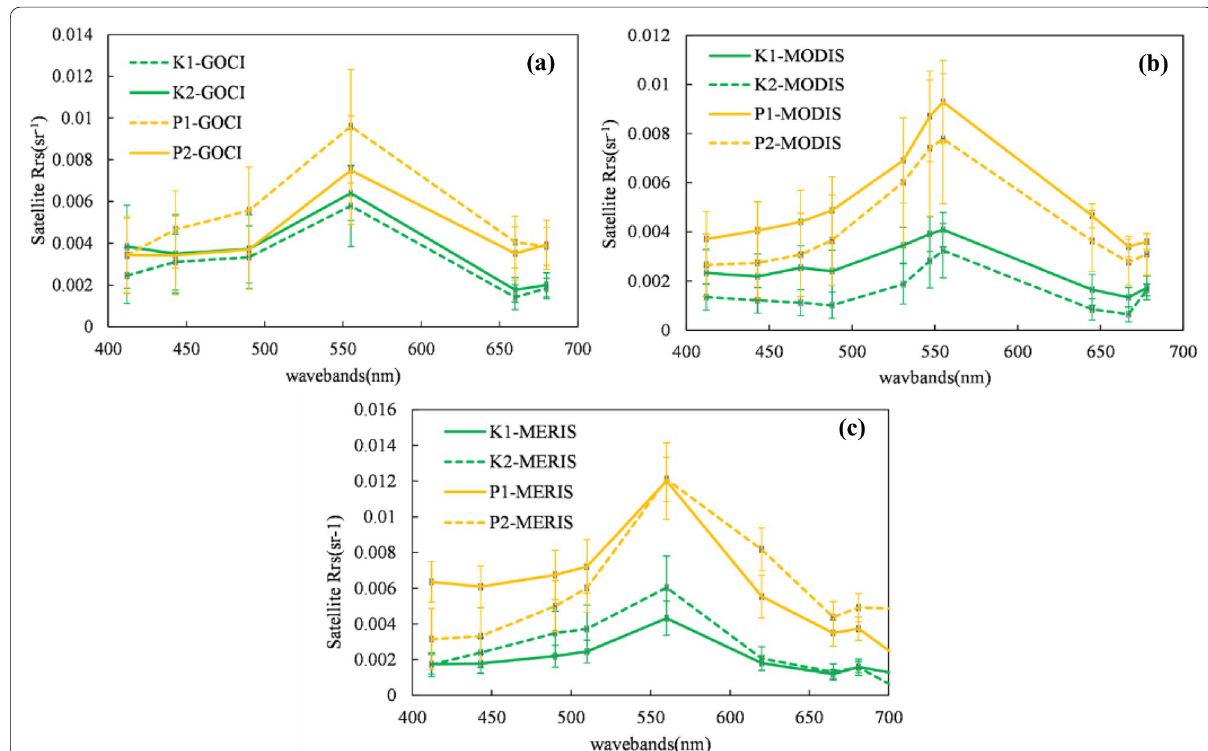
Fig. 6 Satellite R rs ( (cid:31) ) extracted from the bloom regions by a GOCI, b MODIS, and c MERIS images in Figs. 2 and 3. The K1-GOCI, K2-GOCI, K1-MODIS, K2-MODIS, K1-MERIS and K2-MERIS represent the averaged satellite R rs ( (cid:31) ) of K. mikimotoi bloom regions from GOCI, MODIS and MERIS images in Fig. 2. The P1-GOCI, P2-GOCI, P1-MODIS, P2-MODIS, P1-MERIS and P2-MERIS represent the averaged satellite R rs ( (cid:31) ) of P. donghaiense bloom regions from GOCI, MODIS and MERIS images in Fig.